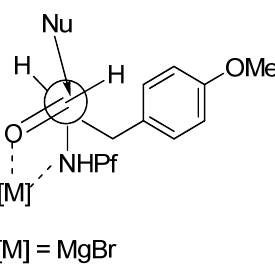
Figure 6. The transition state of syn -selectivity in